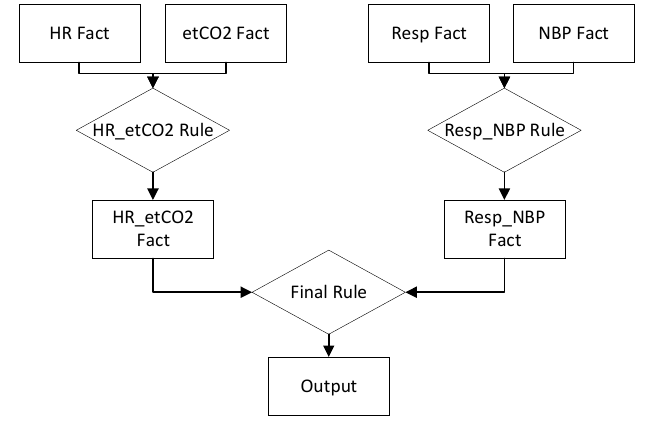
Figure 5. Third GDES network.